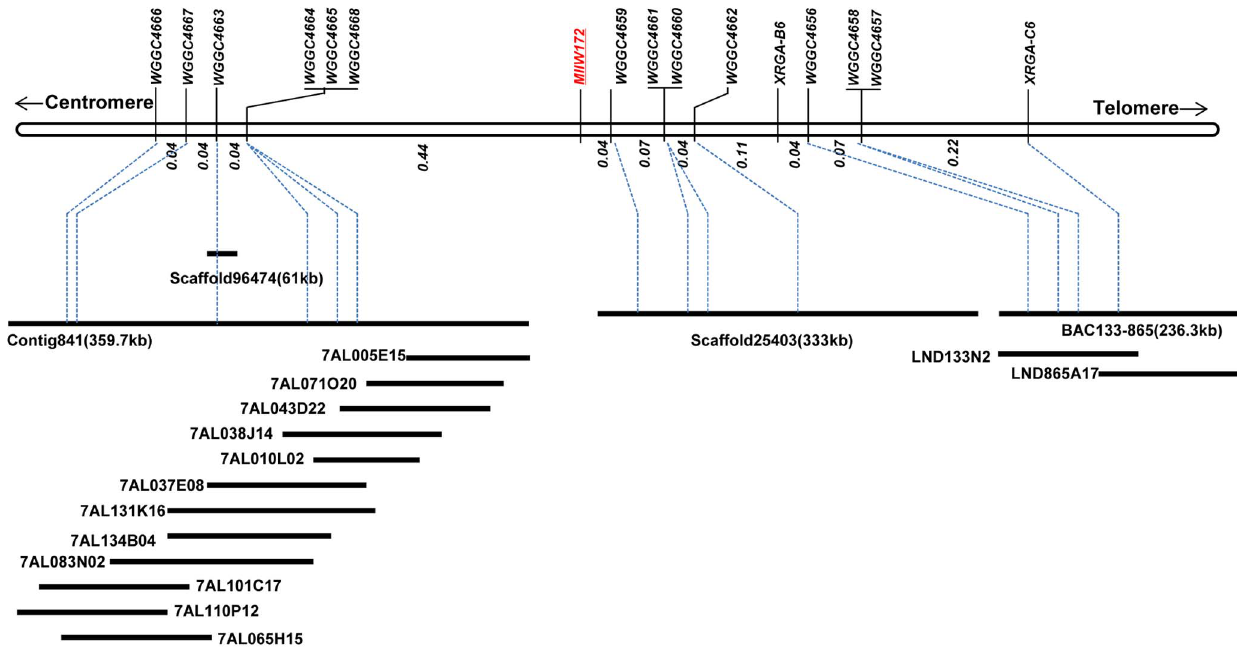
Figure 2. Physical map of the BAC contigs and scaffolds flanking the MlIW172 locus anchored to the high-resolution genetic map. The approximate physical locations of all the newly designed markers are given on the BAC contigs or scaffolds.